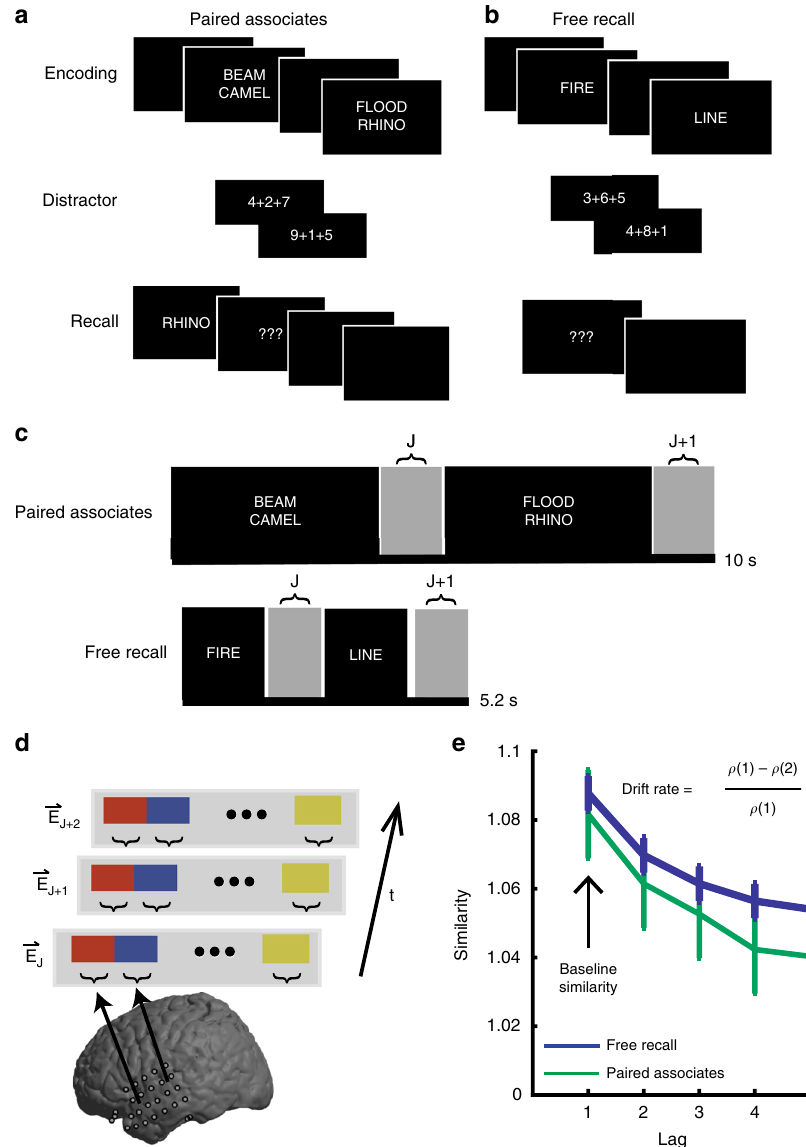
Fig. 1 Neural drift during two verbal memory tasks. a During the paired associates task, pairs of words are sequentially presented on the screen. During retrieval, one word from each pair is presented in random order, and participants are instructed to vocalize the associated word. Each session consisted of up to 25 lists of this encoding-distractor-recall procedure. b During the free recall task, single words are sequentially presented. During retrieval, participants are instructed to vocalize remembered words, in any order. Each session consisted of up to 25 lists. c Interstimulus epochs are used to examine rate of neural drift during encoding. d For every interstimulus epoch, z-scored power in 5 frequency bands from each electrode in the temporal lobe is combined to create a single feature vector for that epoch. e Cosine similarity between vectors spaced apart by different lags is computed. Error bars represent Loftus-Masson con fi dence intervals, across 28 participants who performed the paired associates task, and 48 participants who performed the free recall